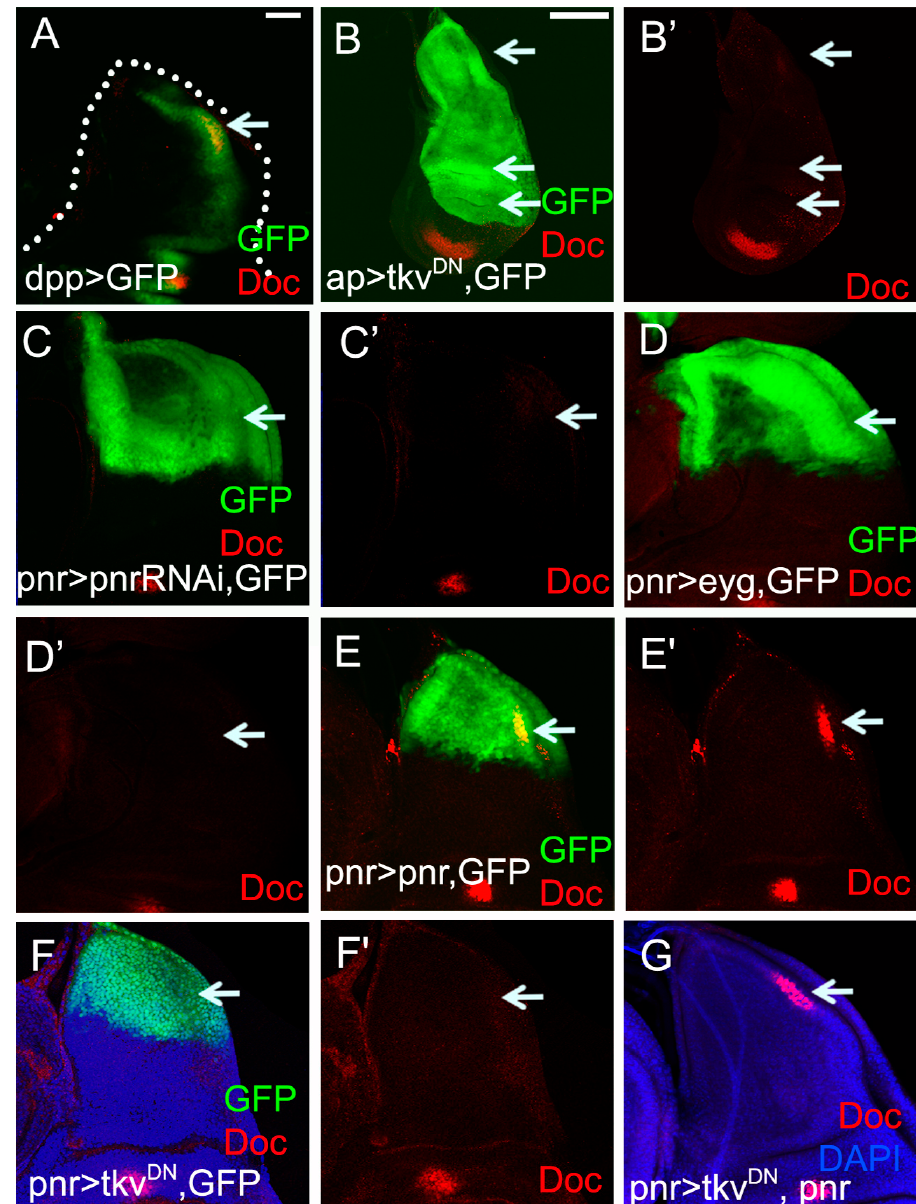
Figure 2. Doc is downstream of Dpp signaling. ( A ) Doc is expressed within the dpp expression region in the posterior notum of wing disc. The dotted line indicates the outline of the wing disc. ( B ) Doc is inhibited ( B’ ) when a dominant negative form of Tkv ( tkv DN ) is expressed in the dorsal compartment by ap-Gal4 driver (white arrows indicate the presumptive dorsal Doc domains). ( C ) Doc is inhibited ( C’ ) when pnr is down-regulated. ( D ) Doc is suppressed ( D’ ) when the eyg is expressed in the notal Pnr-domain. ( E and E’ ) Overexpression of pnr does not affect notal Doc expression. ( F ) Notum Doc expression is reduced ( F’ ) when tkv DN is expressed. ( G ) Doc repression is blocked when pnr is expressed in the pnr > tkv DN background. Scale bar, 2 µ